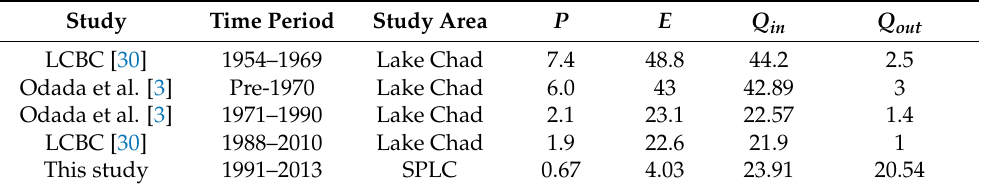
Table 2. Comparison of water budget components (km 3 ) estimated in different studies.